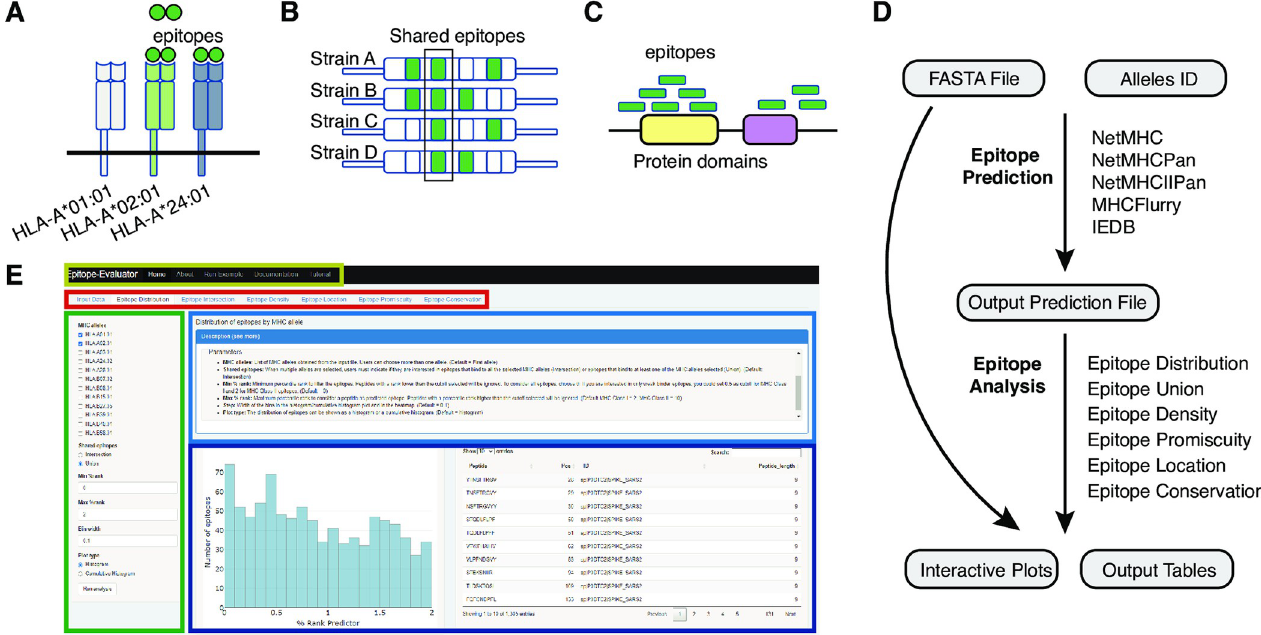
Fig 1. Schematic representation of characteristics of predicted epitopes and workflow of Epitope-Evaluator. (A) The promiscuity of epitopes represents their ability to be recognized by multiple Class I or Class II alleles. (B) The conservation of epitopes allows appropriate immune responses against several pathogen strains. Otherwise, restricted epitopes allow better discrimination across strains such as in immunological tests. (C) Determining the regions or domains enriched or depleted in epitopes helps to propose better peptide-based vaccines. Green circles and rectangles represent predicted epitopes. (D) Workflow to predict and analyze T-cell epitopes. All the current predictors of T-cell epitopes require a FASTA file containing protein sequences and the selection of MHC alleles of interest and retrieve an output prediction file containing a score for each epitope-allele pair (top). The Epitope-Evaluator requires the same FASTA file used as input in the prediction and the output file given by any predictor, and returns different plots and tables depending on the tool used (bottom). (E) Preview of the Epitope-Evaluator online web server. Rectangles indicate each section of the webserver. The title section (yellow), the tools section (red), the parameters section (green), the help section (blue), and the output section